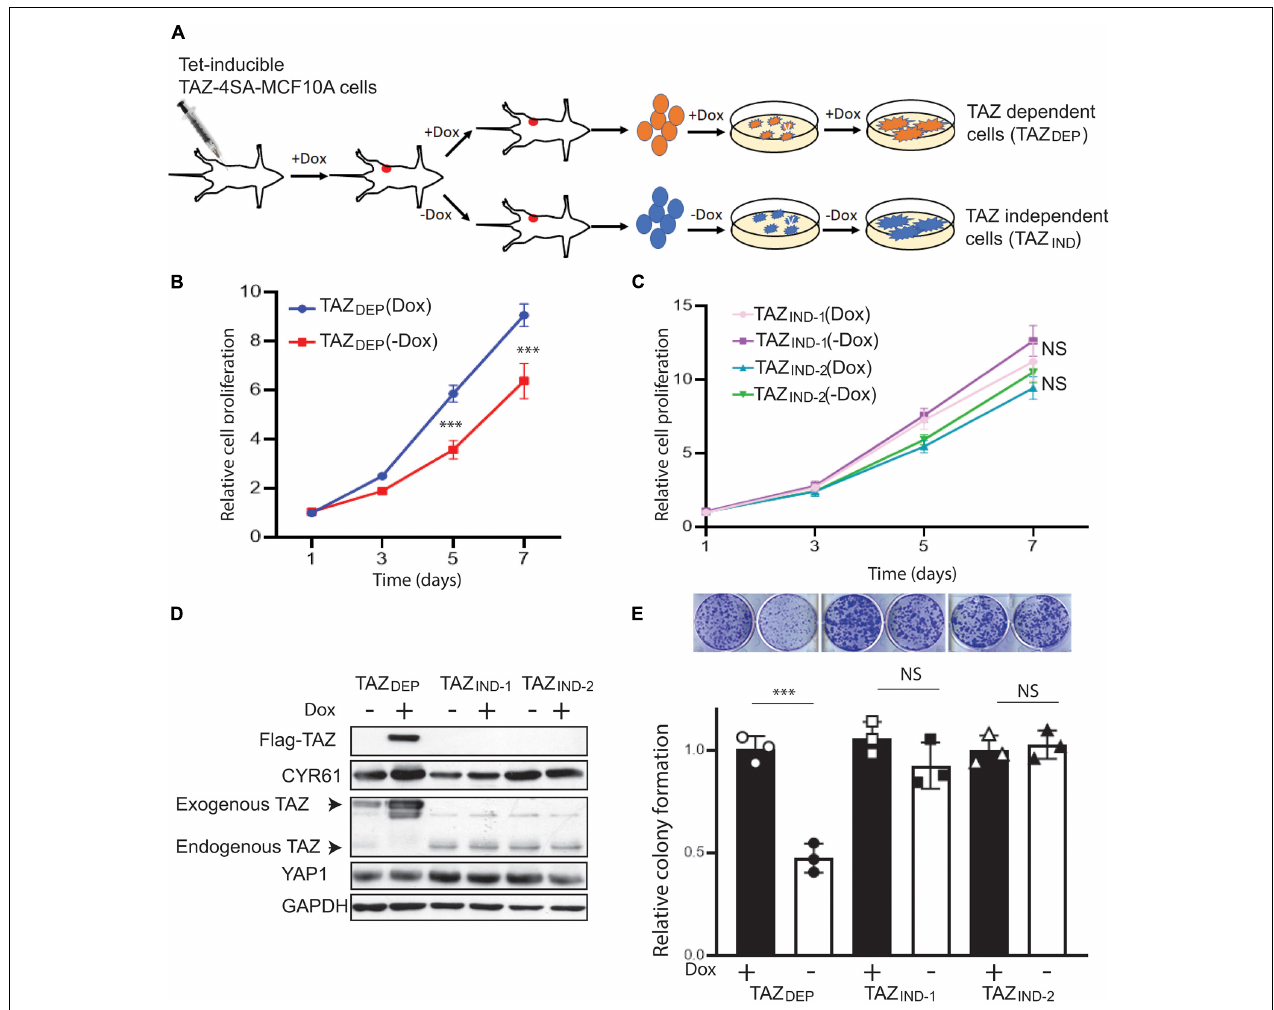
FIGURE 1 | Isolation of TAZ DEP and TAZ IND tumor-derived isogenic cells. (A) Schematic description of the preparation of TAZ DEP and TAZ IND tumor-derived isogenic cells. (B) Cell proliferation assay of TAZ DEP cells in response with or without dox treatment (2 µ g/ml). Data are shown as the mean ± SD. Unpaired two-tailed Student’s t -test: ∗∗∗ p < 0.001. (C) Cell proliferation assay of TAZ IND cells in response with or without dox treatment (2 µ g/ml). Data are shown as the mean ± SD. Unpaired two-tailed Student’s t -test: NS = not significant. (D) Exogenous (Flag-TAZ) and endogenous TAZ, CTGF, and YAP expression detected by immunoblotting. GAPDH was used as a loading control. (E) Representative images and quantification of colony formation of TAZ DEP and TAZ IND cells in response to or without dox treatment. Data are shown as the mean ± SD. Unpaired two-tailed Student’s t -test: ∗∗∗ p < 0.001; NS = not